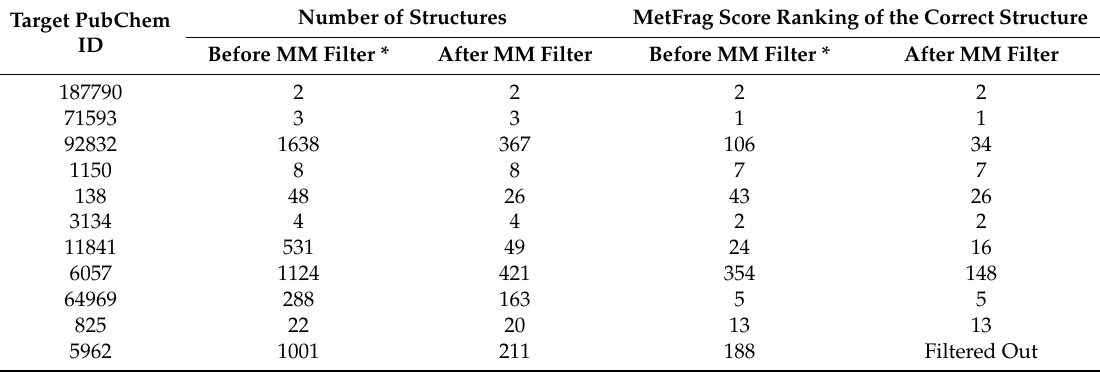
Table 4. Structure filtering with Molecular Mechanics (MM)